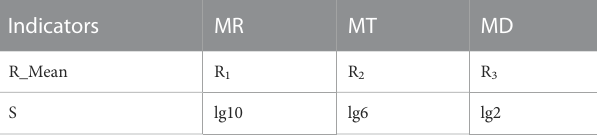
TABLE 1 Seasonal factor of the month to which the event belongs.